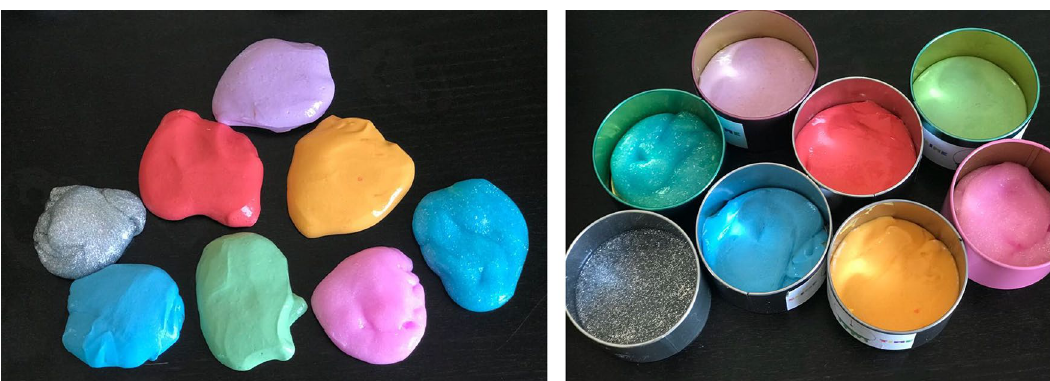
Figure 7. Adding colored clay to make different colored